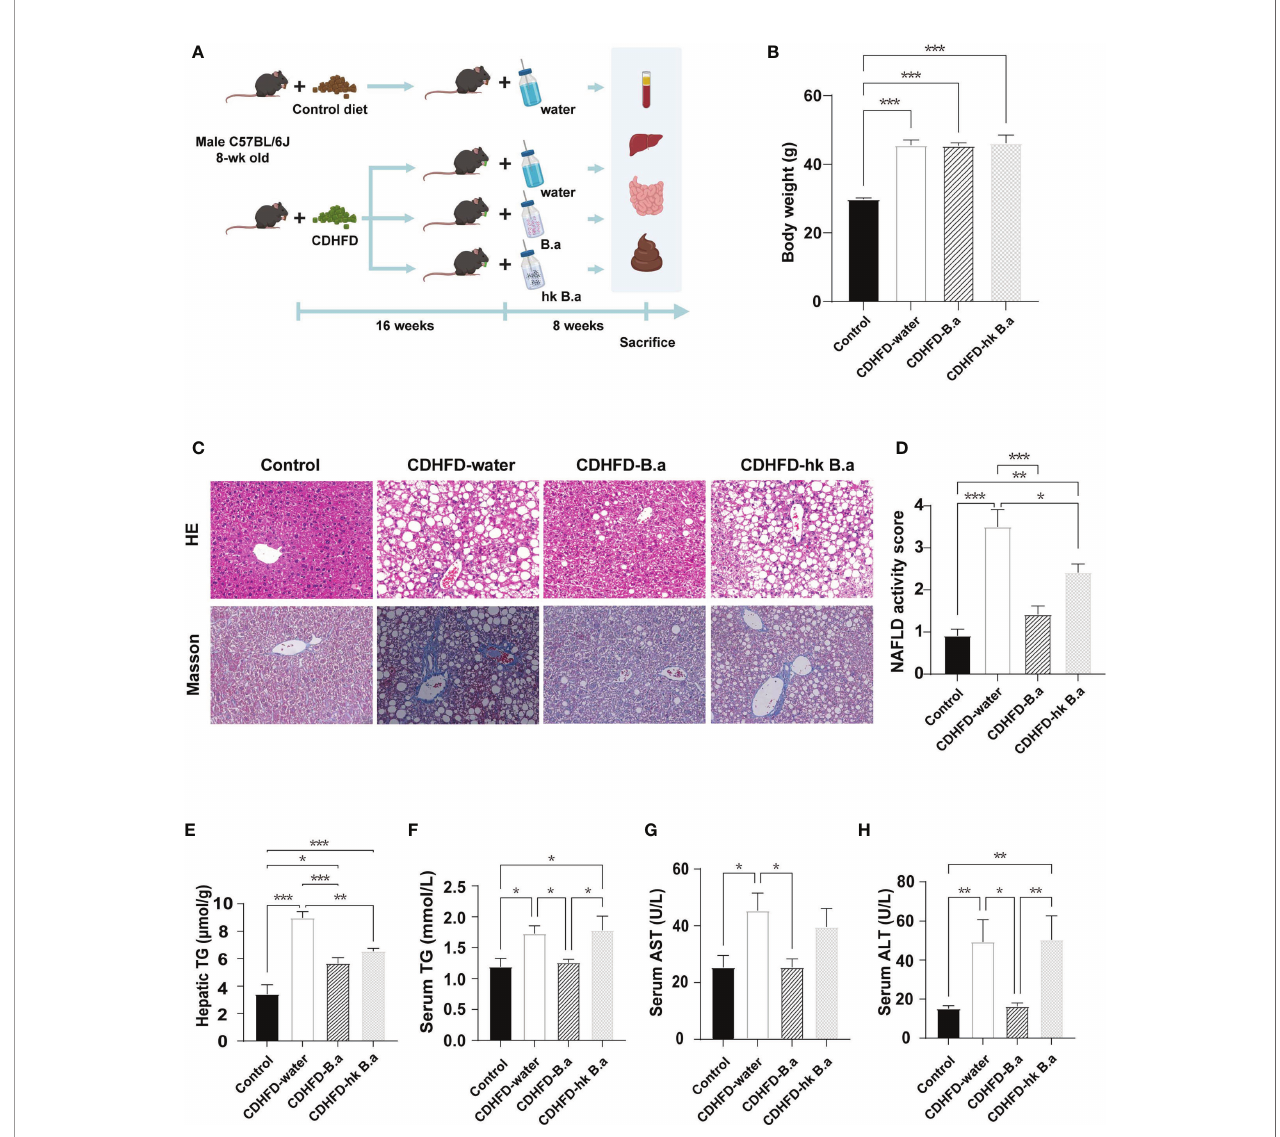
FIGURE 1 | B. adolescentis supplementation alleviated the diet-induced liver steatosis and steatohepatitis in mice. (A) The overall design of the animal experiment. C57BL/6J mice on CDHFD were given drinking water (CDHFD-water), water with live B. adolescentis (CDHFD-B.a), or heat-killed (CDHFD-hk B.a) for 8 weeks. The experiment schematic was created using BioRender.com. (B) Body weight in each group after intervention (n = 6 in each group). (C) Histology of liver with HE and Masson staining. (D) NAS (n = 6 in each group). (E) TG level in liver (n = 6 in each group). (F) The level of serum TG (n = 6 in each group). (G) The level of serum AST (n = 6 in each group). (H) The levels of serum ALT (n = 6 in each group). ALT, alanine aminotransferase; AST, aspartate aminotransferase; CDHFD, choline- de fi ciency high fat diet. HE, hematoxylin- Eosin; NAS, NAFLD activity score; TG, triglyceride. Data are presented as mean ± SEM. Signi fi cance was determined by one-way ANOVA with Fisher ’ s LSD multiple-comparison analysis. *p < 0.05; **p < 0.01; ***p <